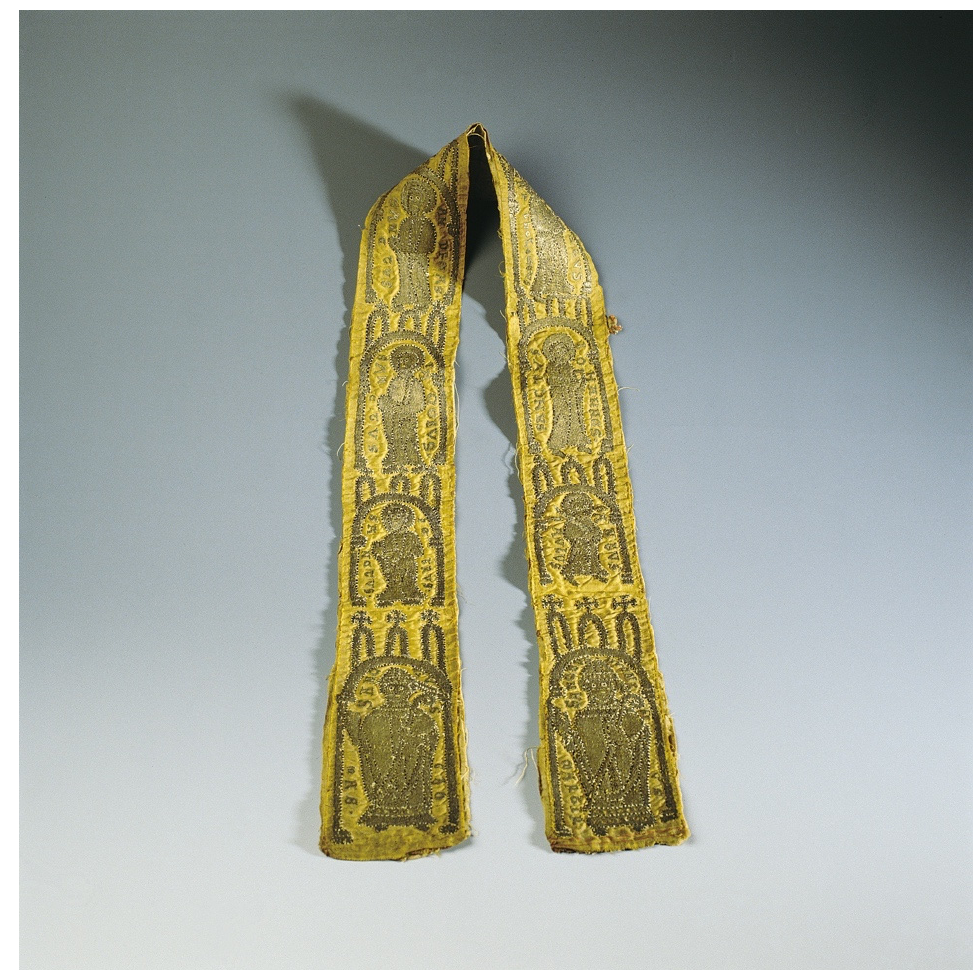
Figure 11. Maniple, first quarter of the 13th century. Donated by the Sisters of Notre-Dame de Na- mur, coll. King Baudouin Foundation, on deposit at the Société Archéologique of Namur and ex- coll. King Baudouin Foundation, on deposit at the Soci é t é Arch é ologique of Namur and exhibited at hibited at the TreM.a—Musée des Arts Anciens, Namur, Belgium. © Hughes Dubois. the TreM.a—Mus é e des Arts Anciens, Namur, Belgium. © Hughes